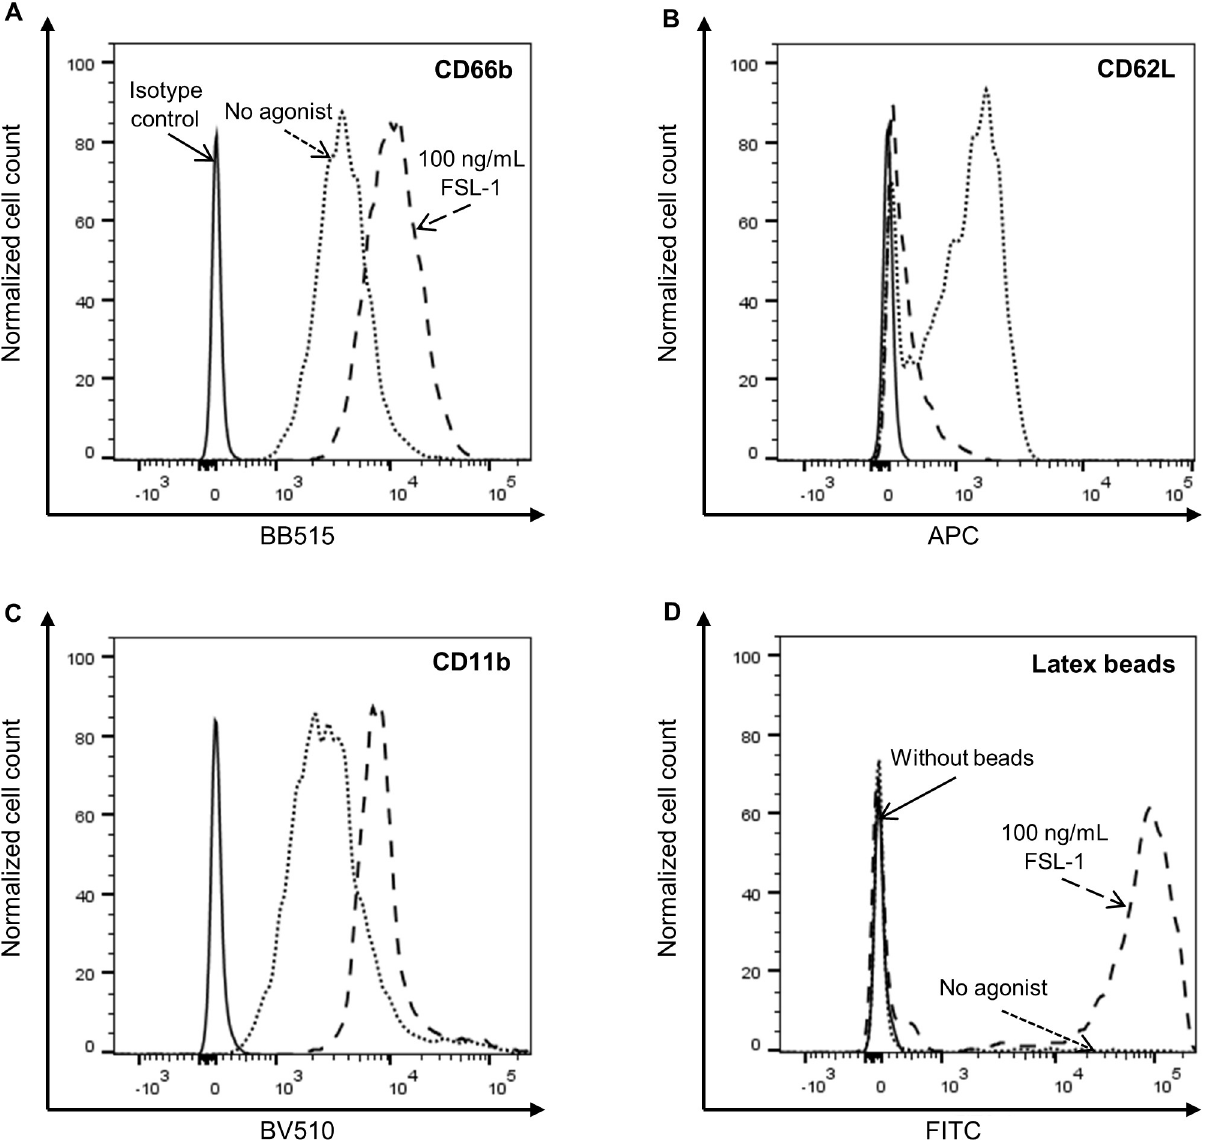
Fig 1. Detection of neutrophil responses to in vitro TLR stimulation by flow cytometry. Highly CD16-positive neutrophils were identified as outlined in S2 Fig. Representative plots of neutrophil CD66b expression (A), CD62L expression (B) and CD11b expression (C) are shown for unstimulated and FSL-1 (100 ng/mL)-stimulated neutrophils following 4 hours of culture. CD66b and CD11b expression levels increase following neutrophil activation, while CD62L levels decrease (CD62L is shed from the neutrophil surface). A representative plot of neutrophil phagocytic activity, as measured by the percentage of latex bead-FITC-positive neutrophils (indicating % of neutrophils that have internalized latex beads conjugated to FITC), is shown for unstimulated and FSL-1-stimulated (100 ng/mL) conditions (D).